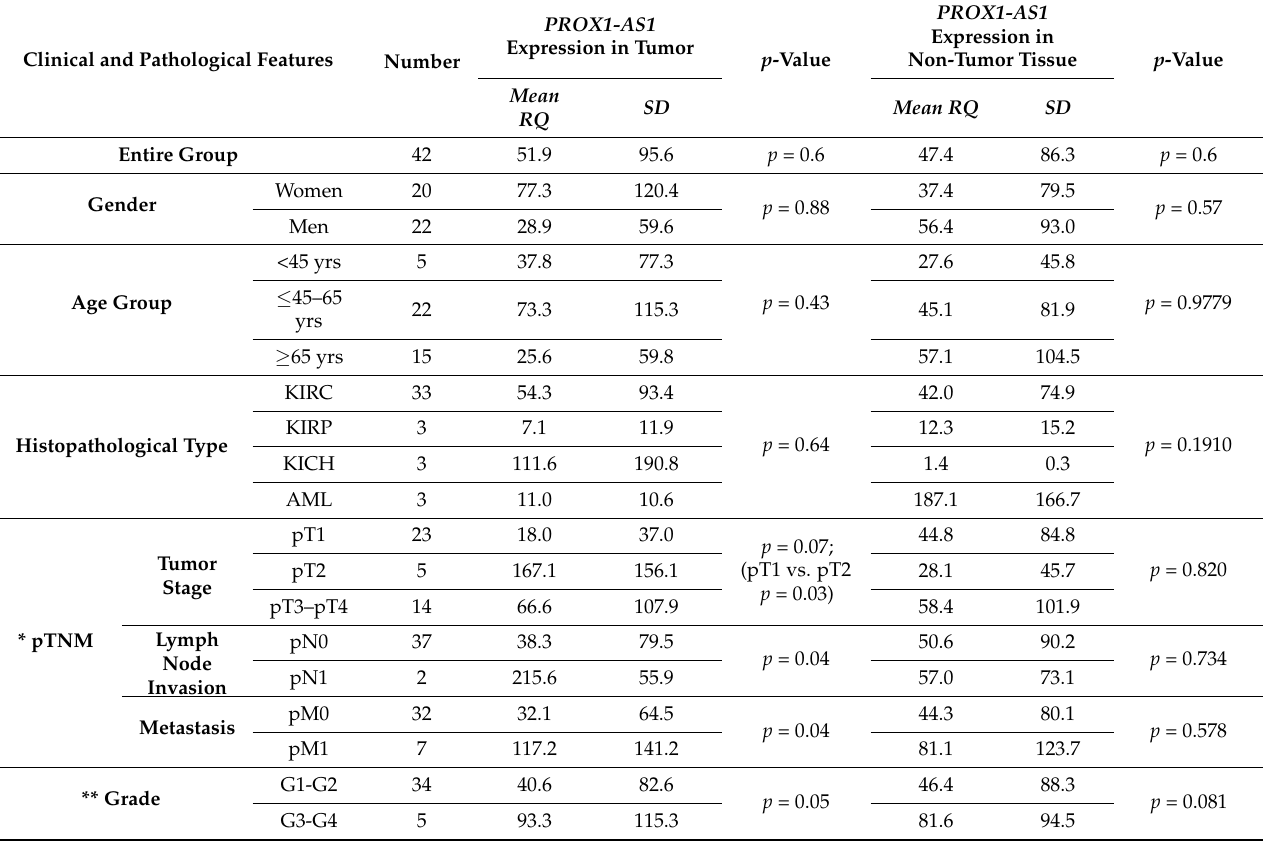
Table 3. Patient clinical and pathological features and PROX1-AS1 lncRNA expression. The relative quantification value (RQ) was calculated as the relative change in PROX1-AS1 transcript expression level compared to the PROX1-AS1 level in the internal control represented by a mixture of RNA extracted from control samples.